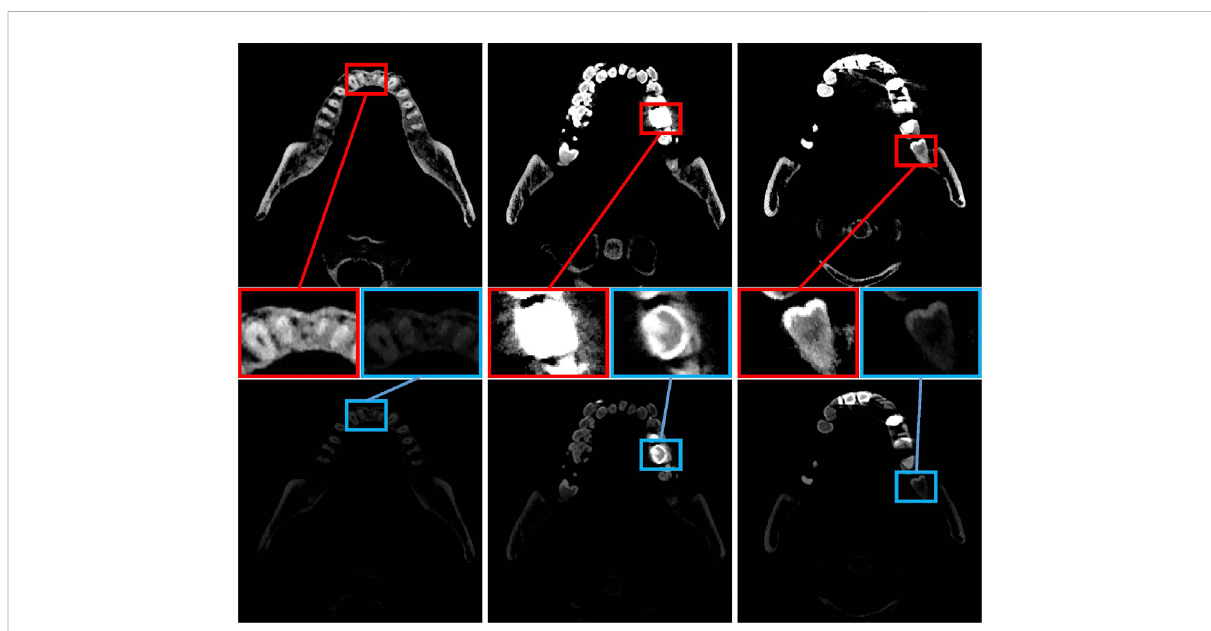
FIGURE 1 ToothCTimagesofthreeslices.ThetopandbottomlinesrepresenttheCBCTimagesofteethobtained bysettingdifferentwindowwidthsand window positions. Teeth or metal may not be separated when the window width is not set correctly. The top line set the window width and window level to 3,010and 2,006.In thebottomline,thewindow widthand window level aresetto 3,074and 4,202,respectively, as con fi